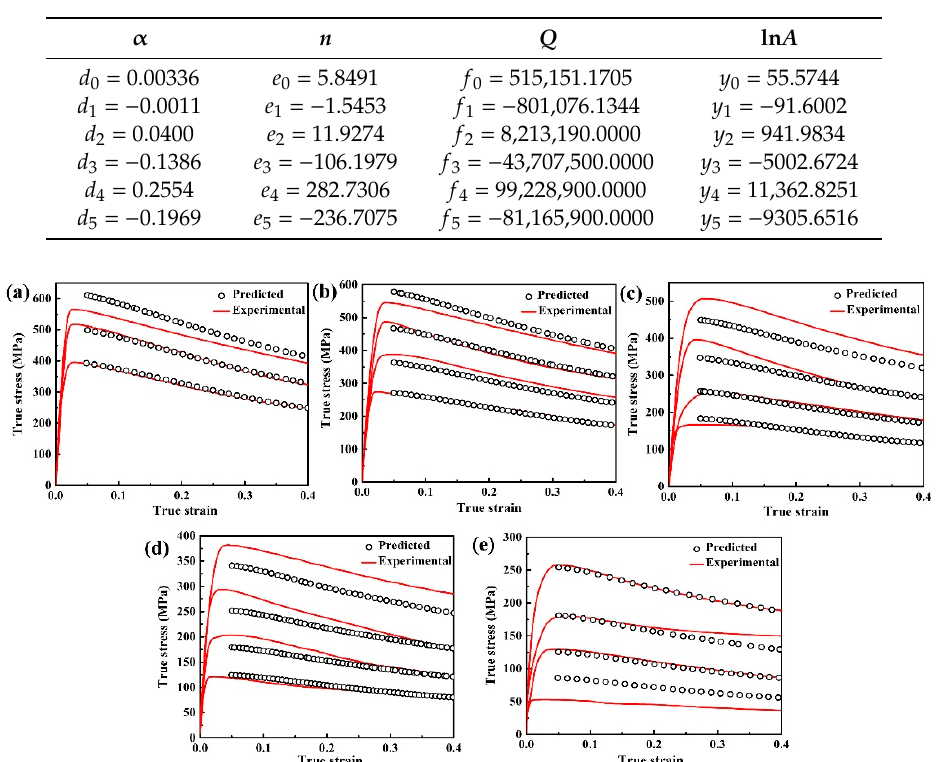
Figure 9. Comparison between the predicted stresses by the Arrhenius model and the experimental ones: ( a ) 700 °C, ( b ) 750 °C, ( c ) 800 °C, ( d ) 850 °C, and ( e ) 900 °C.